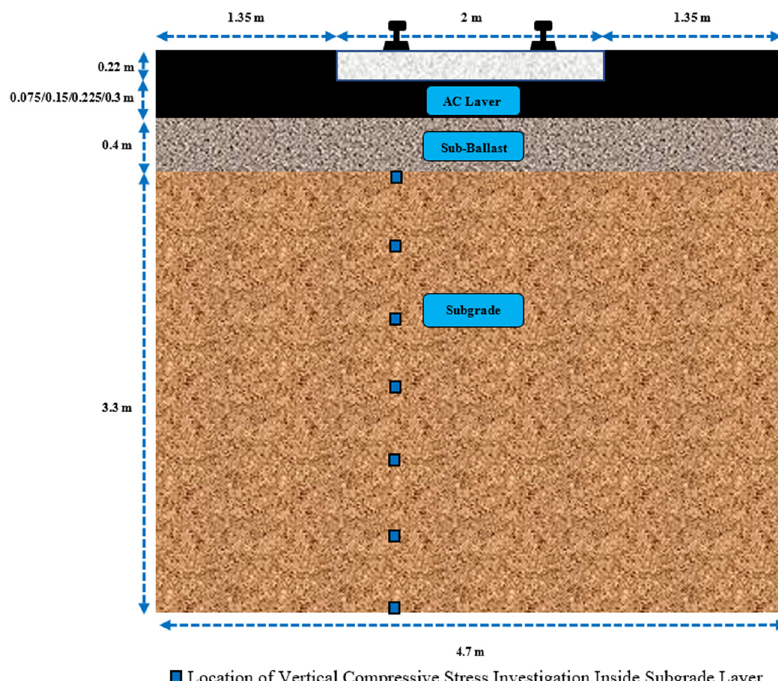
Figure 3: Asphaltic overlayment track geometric for numerical